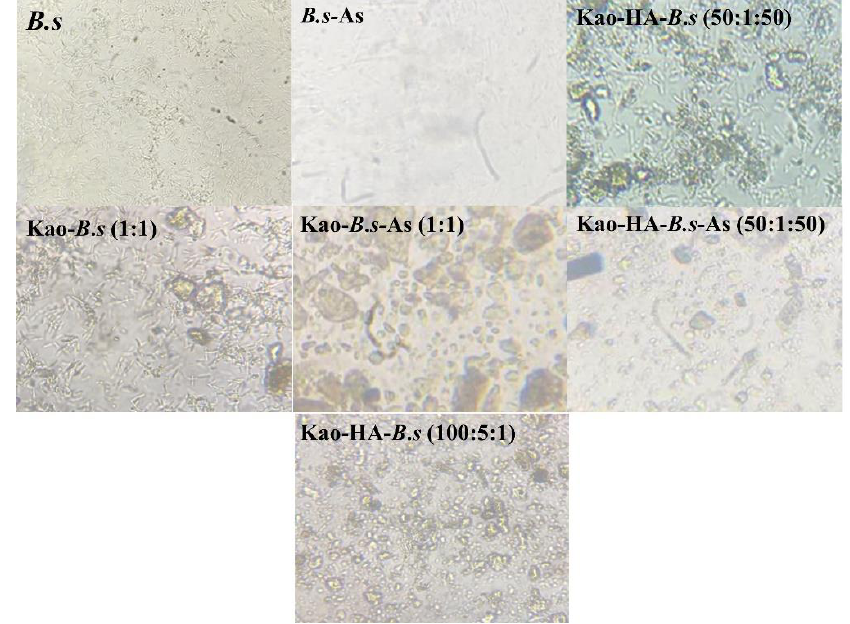
Figure 8. Optical microscopy of composites before and after As(V)